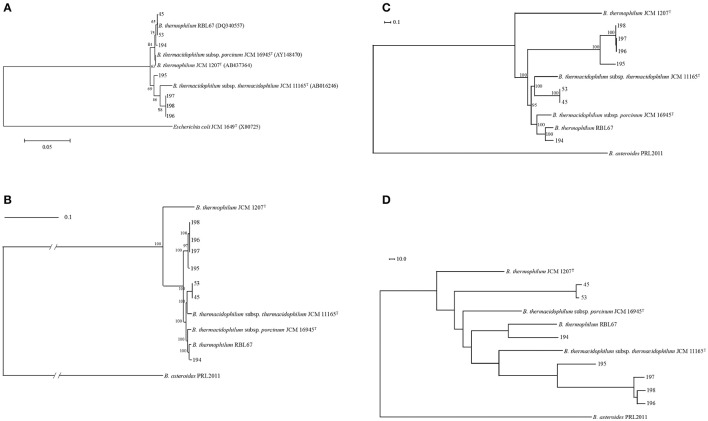
Phylogenetic relationship of Bifidobacterium thermacidophilum strains of various origins. (A) Neighbor-joining phylogenetic tree of 16S rRNA of Bifidobacterium thermacidophilum strains of various origins with reference strains, (B) A maximum likelihood phylogenetic tree of core CDSs of Bifidobacterium thermacidophilum strains of various origins with reference strains, (C) A consensus parsimony tree based on all of the SNPs of Bifidobacterium thermacidophilum strains of various origins with reference strains, (D) A neighbor-joining dendrogram of the presence/absence matrix of the orthologs of Bifidobacterium thermacidophilum strains of various origins with reference strains. The figures denote the strain numbers.